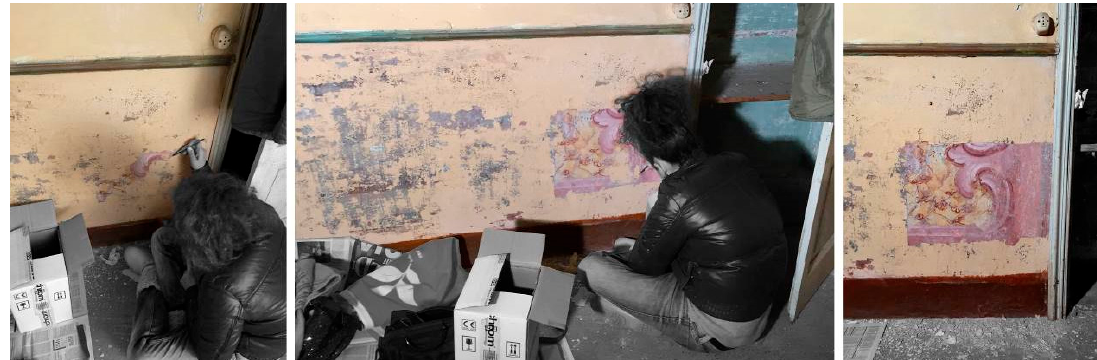
Figure 12. Execution of stratigraphic investigations in the lower part of the wall without frescoed medallions (second room).